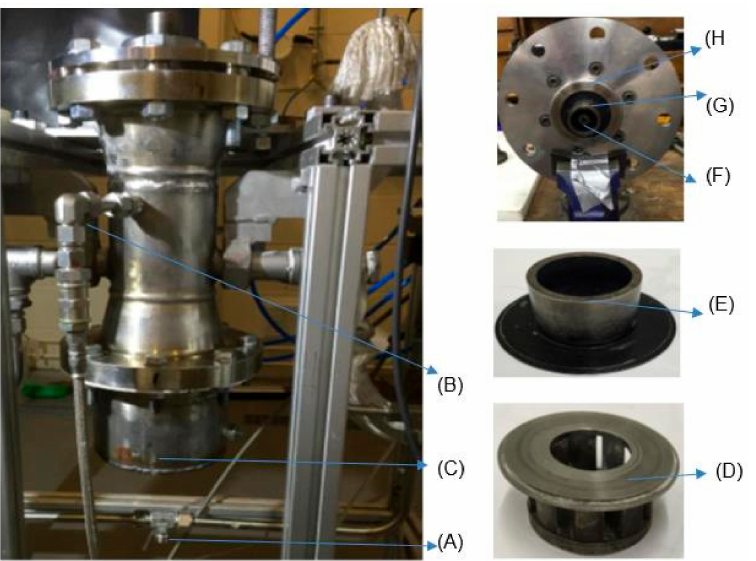
Figure 1. Experimental setup.